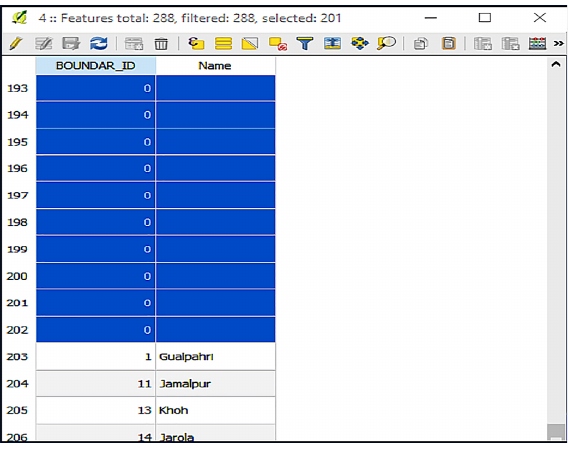
Fig. 4. Duplicate